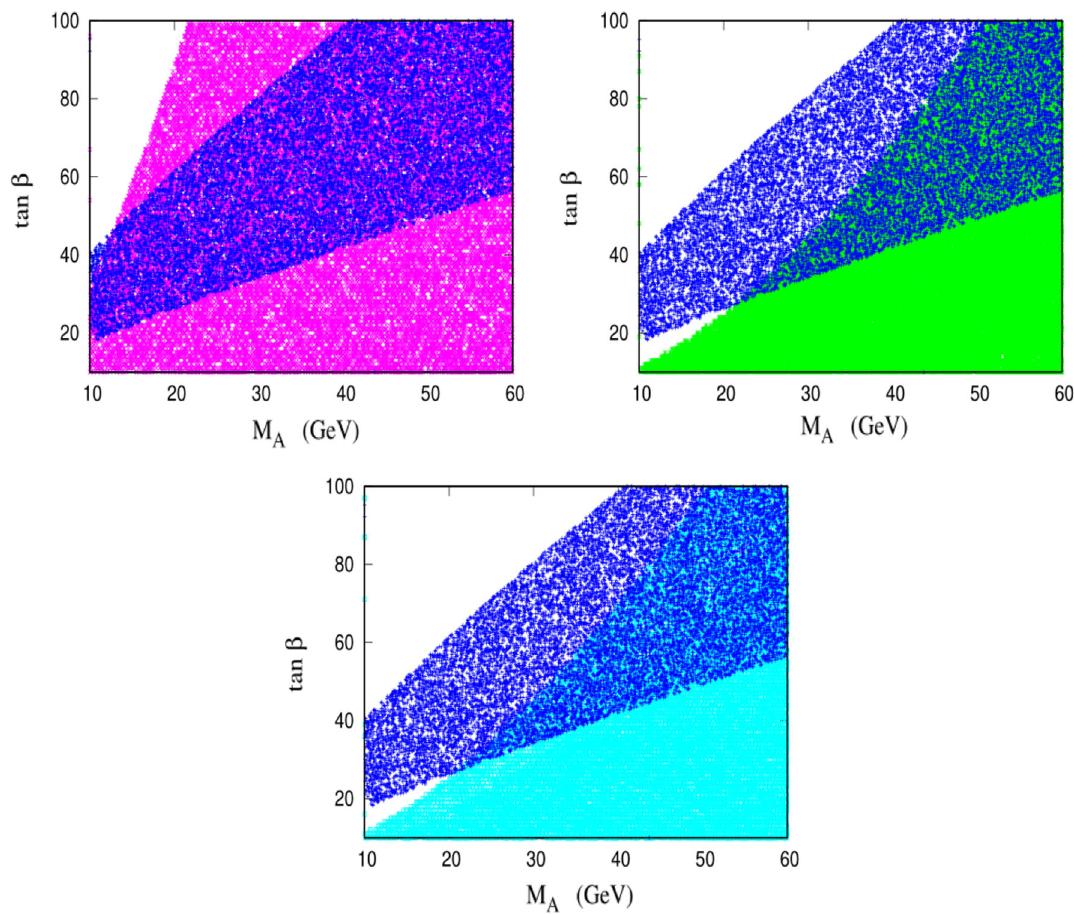
Fig. 2 The magenta, green and cyan regions are the allowed range for μ → e γ , τ → e γ and τ → μγ respectively. The blue band is the allowed 3 σ allowed range for muon anomaly. The overlapping regions satisfy both constraints. The flavor changing couplings are taken to